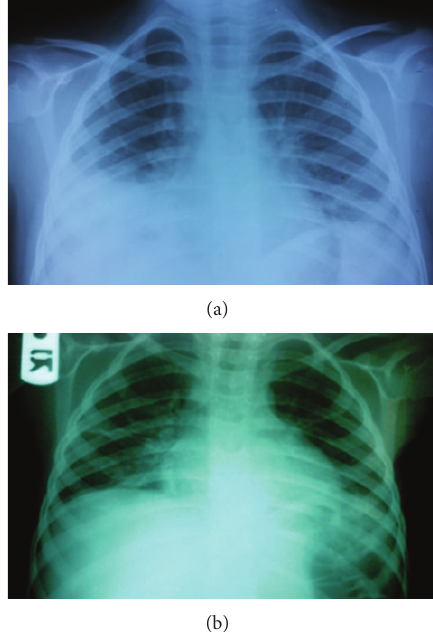
Figure 2: Chest X-ray in our patients with Sweet’s syndrome: (a) pleural effusion in acute phase before treatment, (b) after methylprednisolone pulse